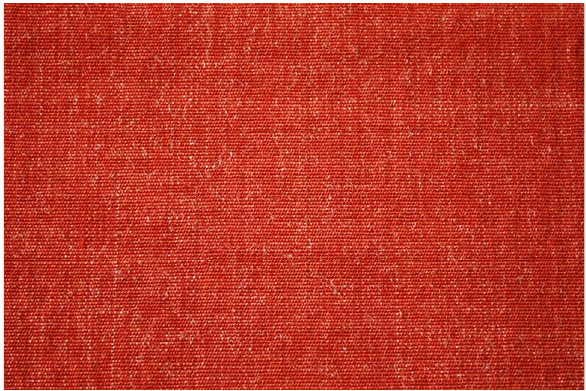
Figure 2. Sample with label 20/6/21.